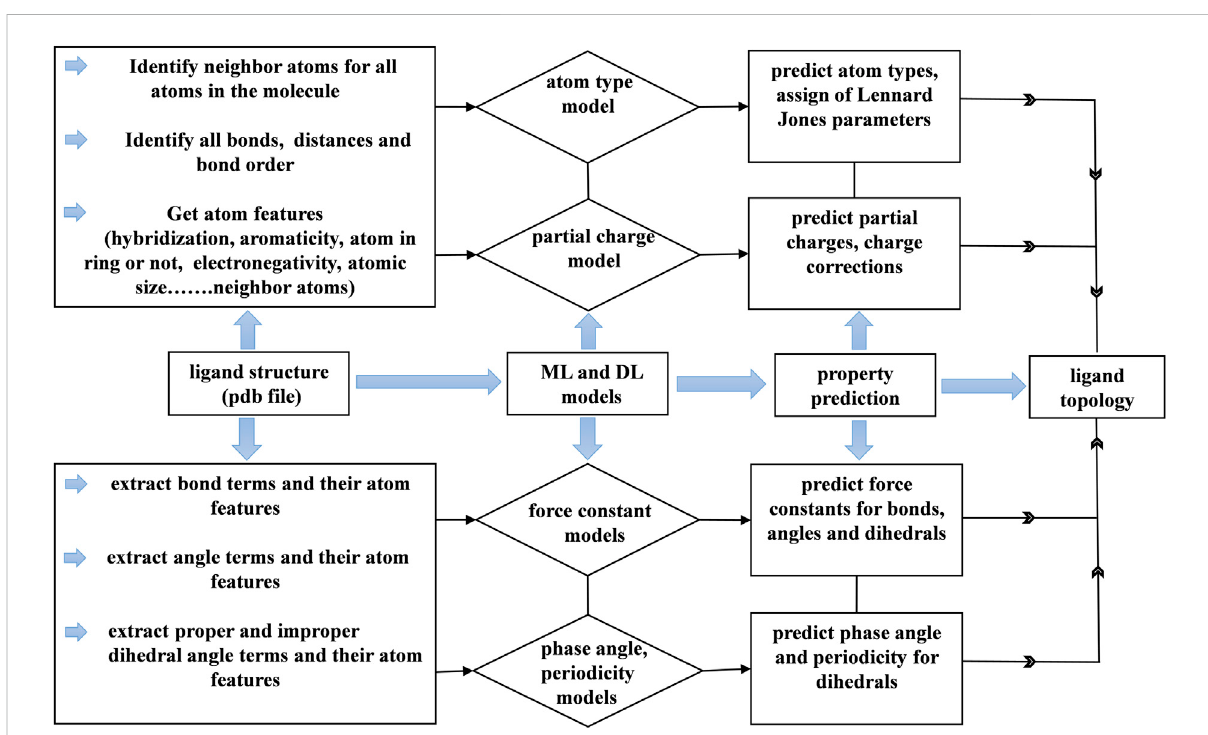
FIGURE 10 Work fl ow of the generation of the topology for small drug-like molecules using machine learning and deep learning